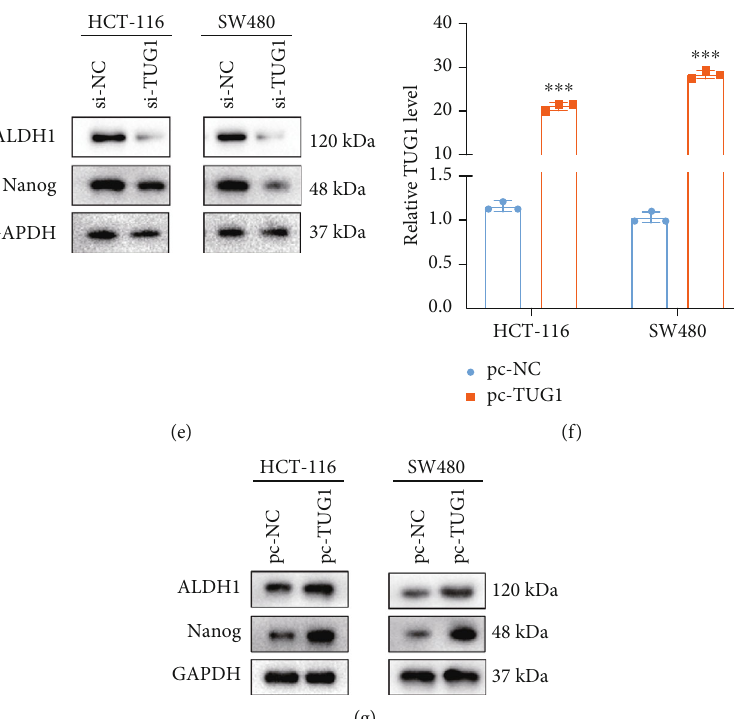
Figure 1: Regulation of lncRNA TUG1 on the characteristics of CRC stem cells. (a) Flow cytometry analysis of CD133 + /CD44 + and CD133 − /CD44 − cells sorted from colorectal cancer (CRC) cell lines HCT-116 and SW480. (b) Quantitative real-time PCR (qRT-PCR) was carried out to quantify the lncRNA TUG1 expression in CD133 + /CD44 + and CD133 − /CD44 − cells. (c) si-TUG1 and its control were transfected into SW480 and HCT-116 cells. The expression of lncRNA TUG1 was assessed by qRT-PCR. (d) The formation of clonal spheres was assessed by sphere formation assay (scale bar: 100 μ m). (e) The protein levels of ALDH1 and Nanog in SW480 and HCT- 116 cells were measured by Western blot. (f) pcDNA-TUG1 was transfected into SW480 and HCT-116 cells. qRT-PCR was conducted to quantify the lncRNA TUG1 expression. (g) The protein levels of ALDH1 and Nanog in SW480 and HCT-116 cells were detected using Western blot analysis. ∗∗ P < 0 : 01 vs. CD133 − /CD44 − . ∗∗∗ P < 0 : 001 vs. CD133 − /CD44 − , pc-NC, or si-NC. NC: negative